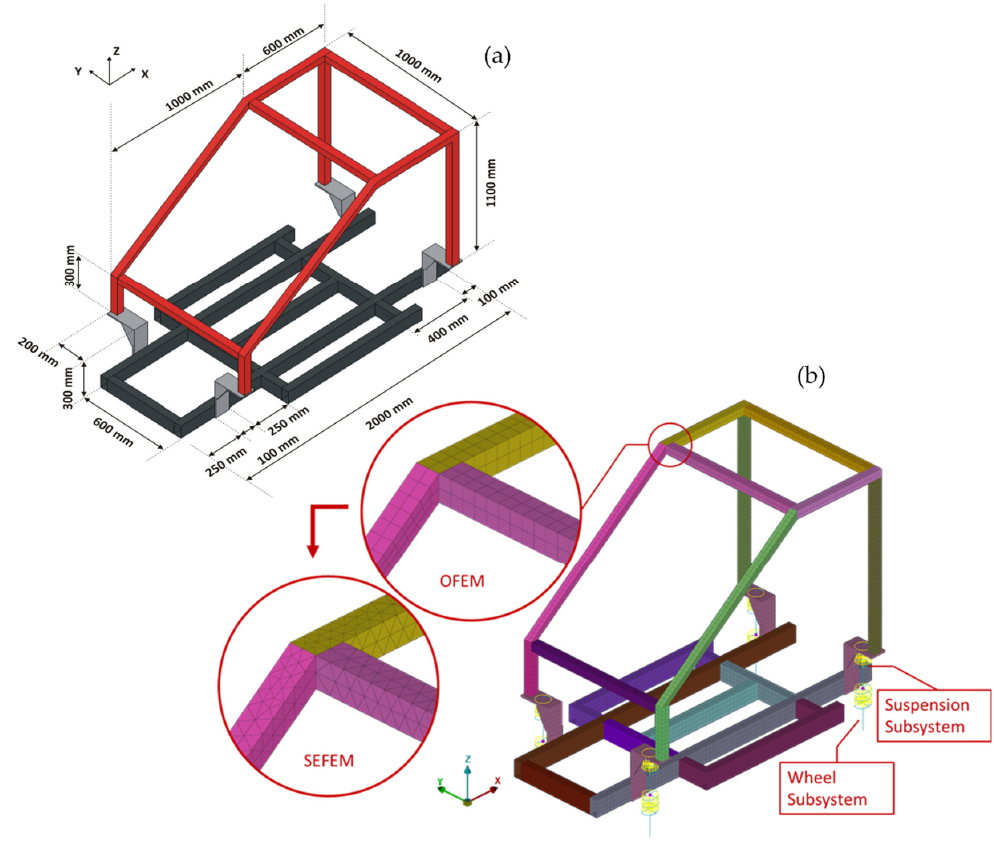
Figure 4. ( a ) Dimensions of the frame substructure Optimal and ( b ) FE Model (OFEM) and Simulated Experimental FE Model (SEFEM).